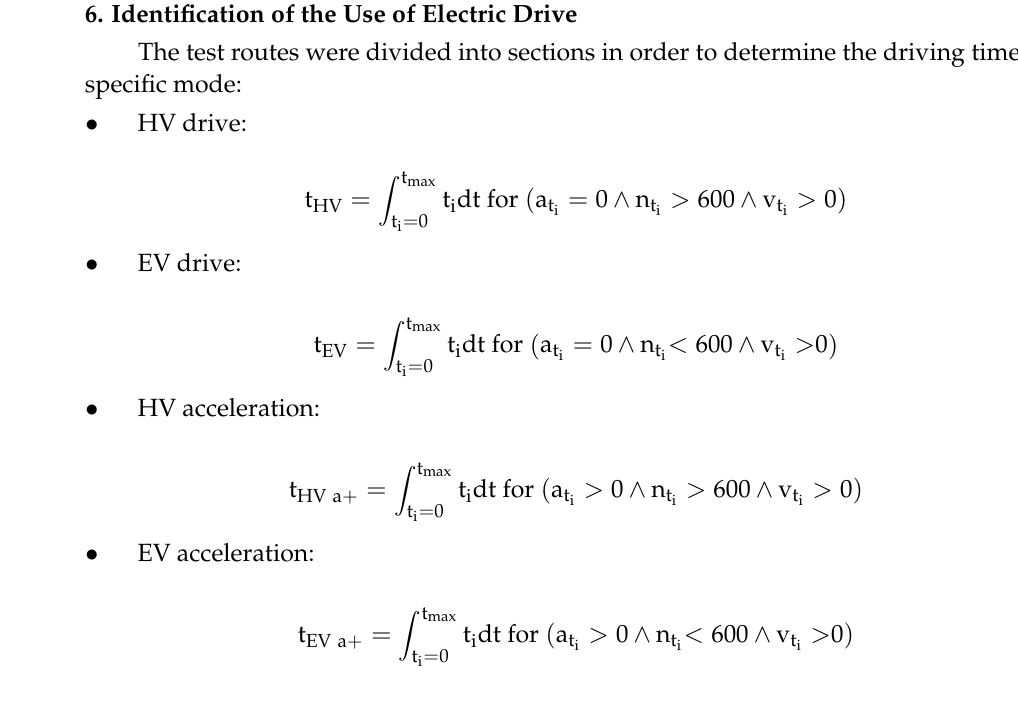
during vehicle braking, charging and discharging.